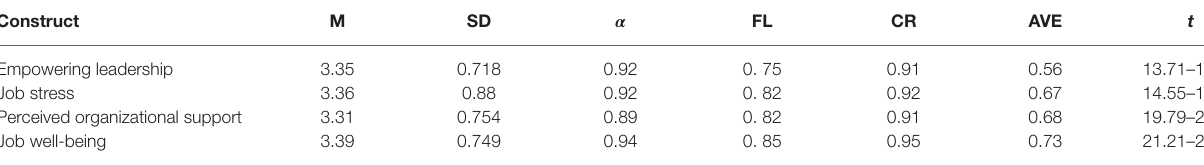
TABLE 2 | Reliability and validity analysis. Construct